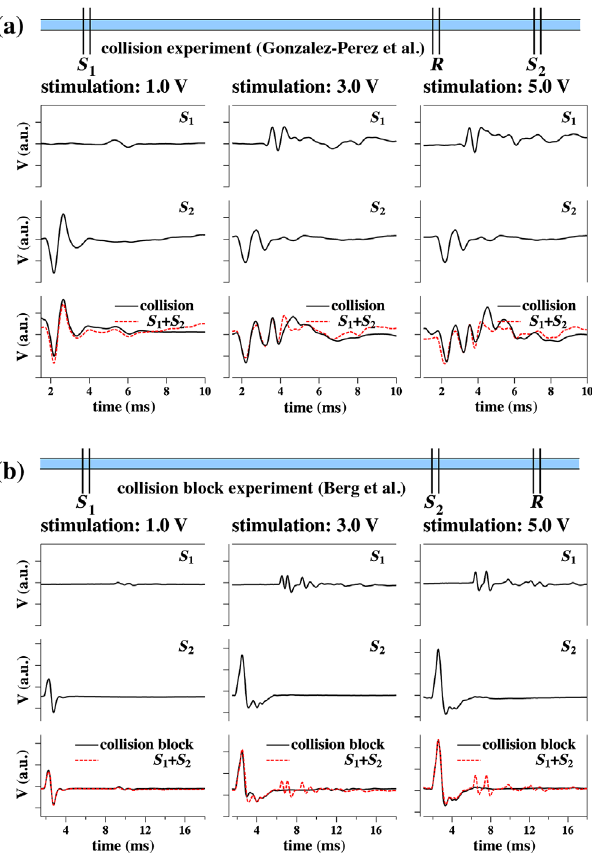
FIG. 1. (a) The recording electrodes are between stimulation sites S 1 and S 2 . We show the signals from S 1 only (top row), S 2 only (middle row), and the collision experiment (bottom row) at three different stimulation voltages. At all voltages, the sum of the individual signals from S 1 and S 2 and the signal after simulta- neous stimulation are very similar or identical. This result implies that the pulses have passed through each other. (b) The experi- ment by Berg2017 (recording site at the distal end of the nerve after stimulation sites S 1 and S 2 ) shows a different outcome. While the sum of the individual signals is identical to the postcollision pulse for a stimulation of 1 V, the signal from S 1 is increasingly inhibited for higher